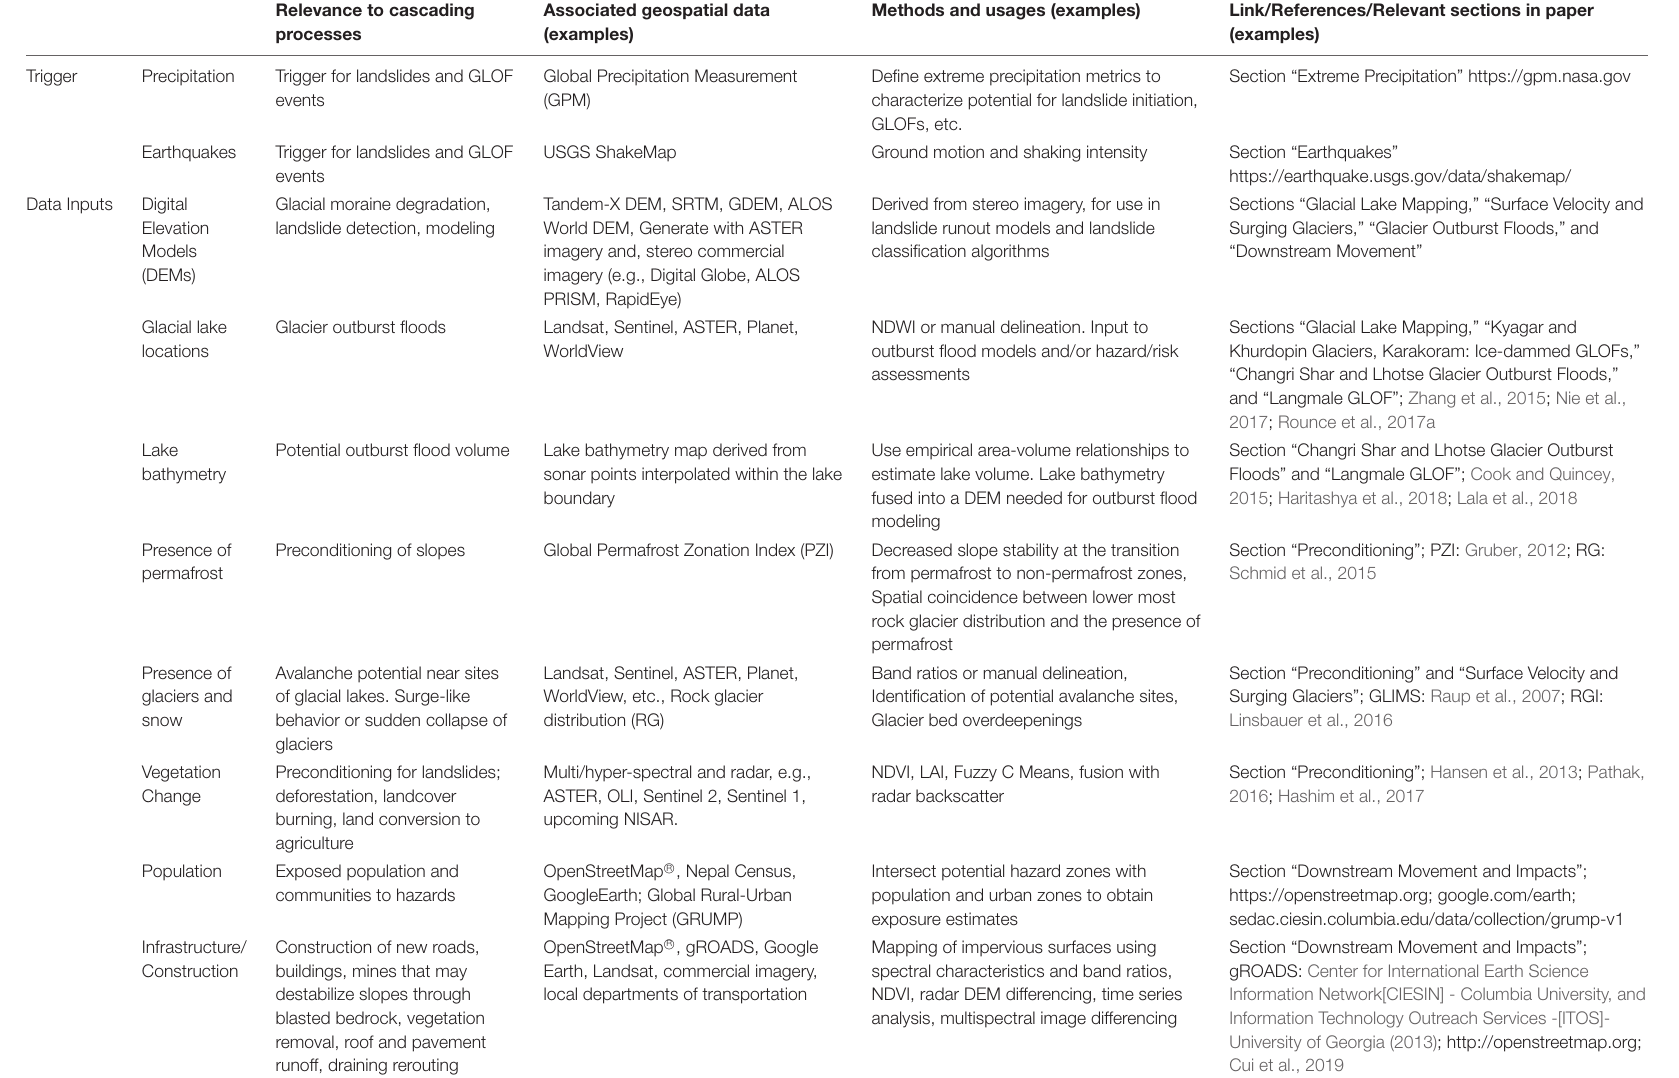
TABLE 1 | Description of relevant processes and elements involved in cascading